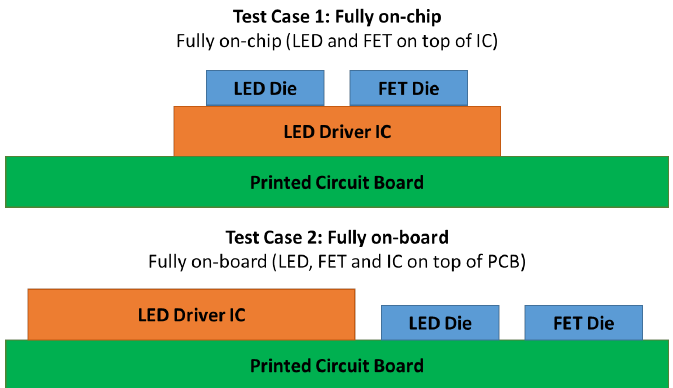
Figure 1. Illustration of DoE based on on-chip or on-board integration of LED and FET